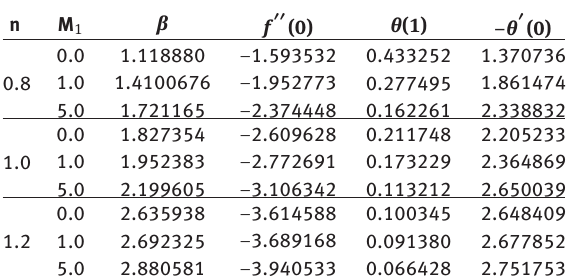
Table 2: Values for β , f (cid:2)(cid:2) (0) , θ (1) and − θ M 1 with M = 0.5, S = 0.8, Pr = 1.0, Nr = 0.5, Ec = 0.1, Q = 0.05 and ϵ = 0.1 .